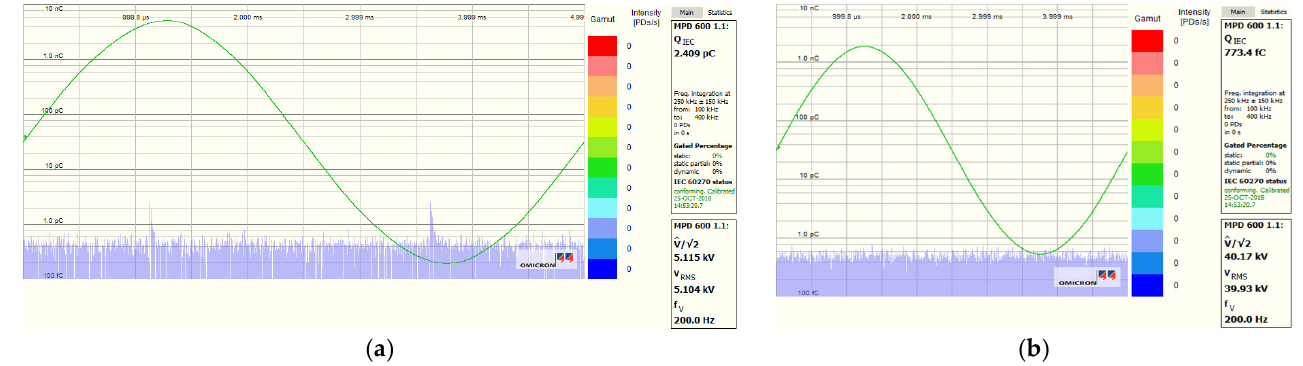
Figure 20. Experimental test results ( a ) without the additional capacitor, and ( b ) with the additional capacitor, at a testing voltage of 40 kV rms .